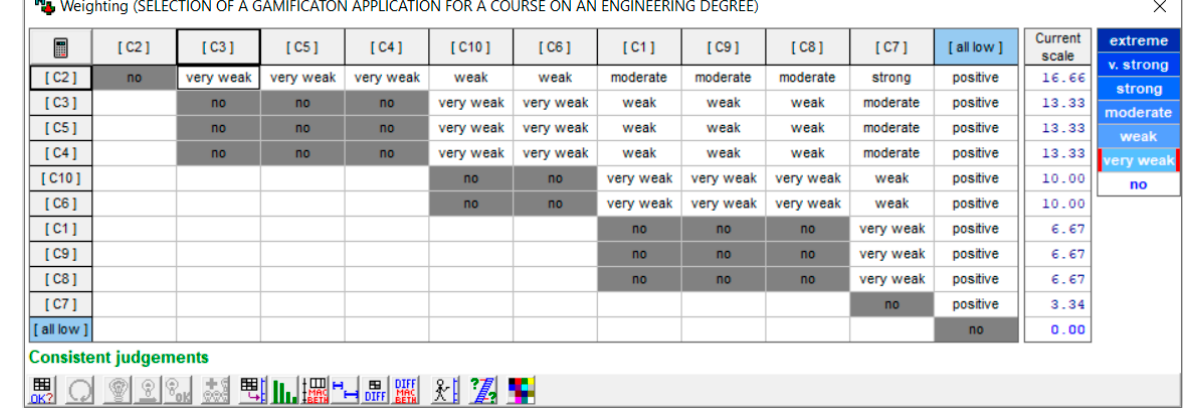
Figure 5. MACBETH judgement matrix.